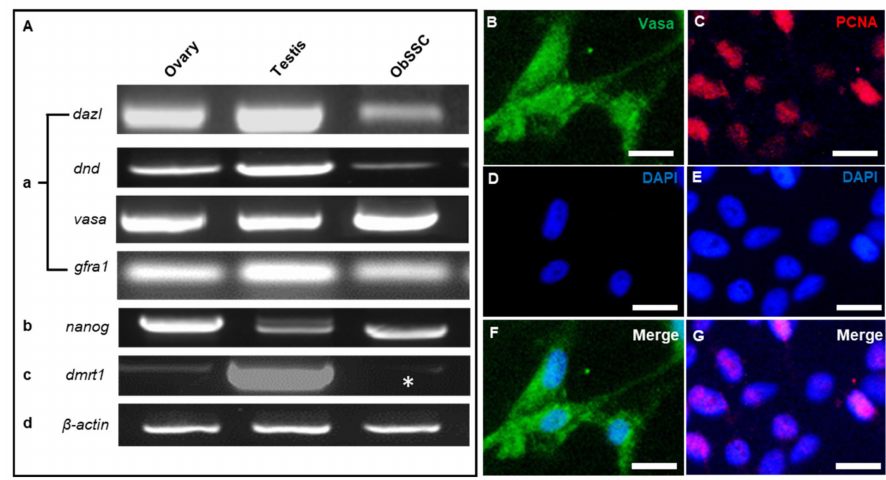
Figure 3. PCR and immunofluorescence analysis of ObSSCs. ( A ) Expression of germ cell markers by RT-PCR of total RNA from ObSSCs and adult gonads with primers for dazl , dnd , vasa , and gfra1 . ( B ) Expression of stem cell marker by RT-PCR with primers for nanog . ( C ) Expression of Sertoli cell marker by RT-PCR with primers for dmrt1 (asterisk). ( D ) Actin expression was determined for